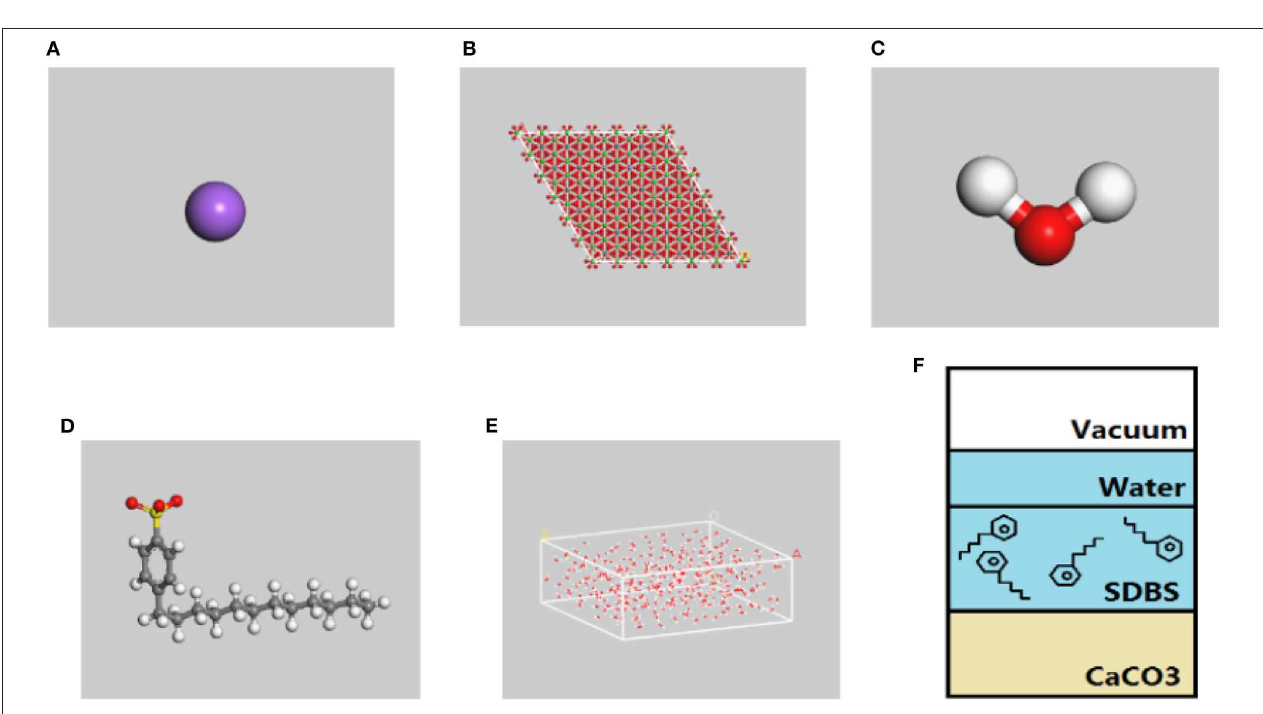
which gradually formed half micelles (400 ps; Figure 3C ). At (600 ps; Figure 3D ) where they were finally adsorbed (800 ps; Figure 3E ). As a result of the difference in the concentrations between the upper water layer and the emulsifier